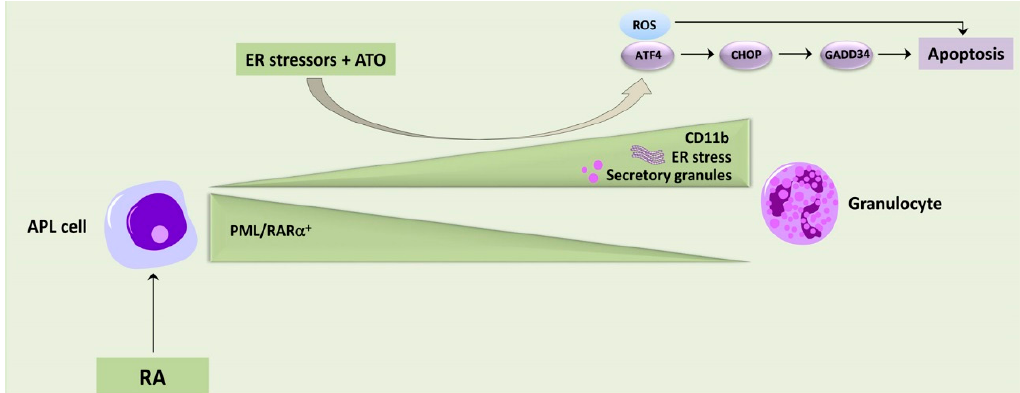
Figure 4. RA treatment drives differentiation of acute promyelocytic leukemia (APL) cells (as documented by the increased expression of the myeloid differentiation marker, CD11b, and the degradation of promyelocytic leukemia-retinoic acid receptor α (PML-RAR α) ) which is accompanied by enhanced endoplasmic reticulum (ER) stress due to the production of secretory granules. In presence of retinoic acid (RA), leukemic cells become more sensitive to low concentrations of ER stressors (e.g. tunicamycin) and to arsenic trioxide (ATO), that induce apoptosis via unfolded protein response (UPR) and reactive oxygen species (ROS). Other abbreviation used are: ATF4: Activating transcription factor 4; CHOP: C/EBP-homologous protein; GADD34: Growth arrest and DNA damage-inducible protein 34.